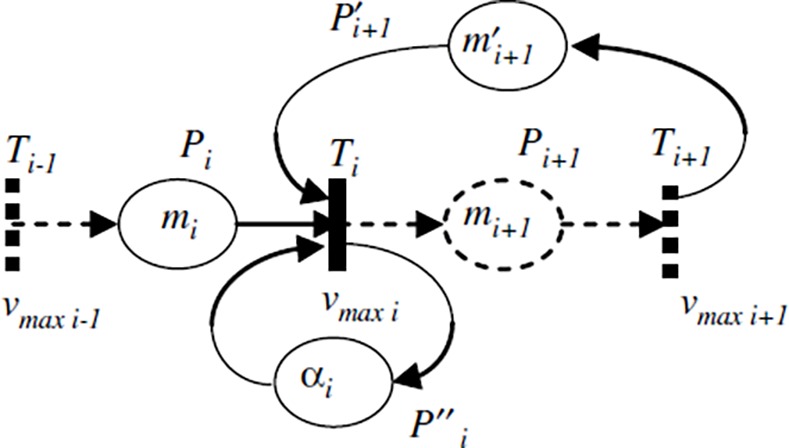
VCPN model of segment i of the motorway.